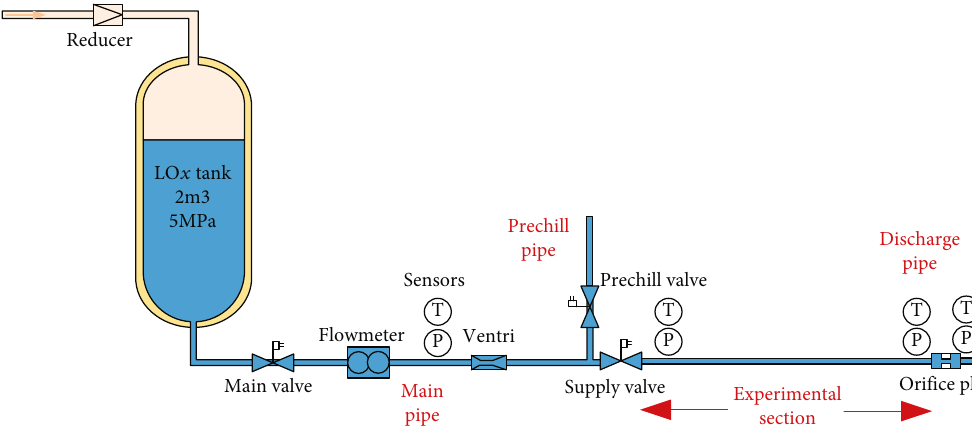
Figure 1: Experimental system of the present